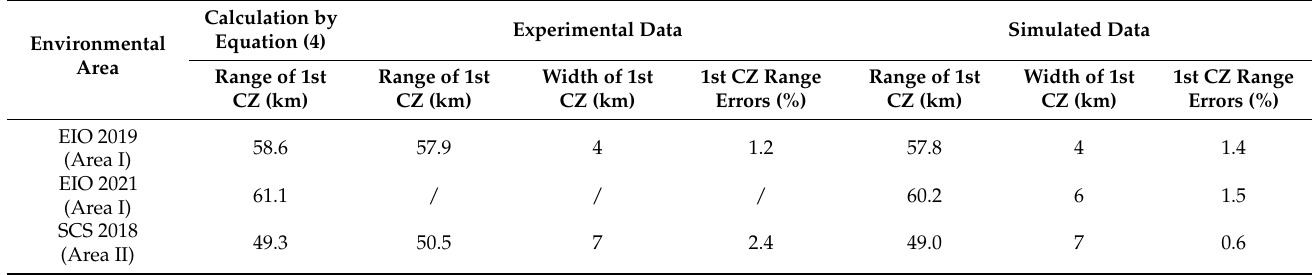
Table 1. The first CZ range and width corresponding to different experiments.